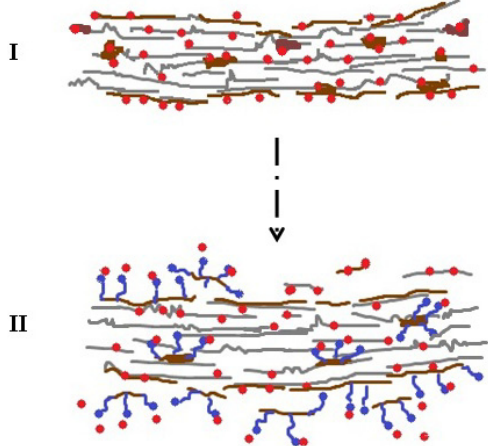
Figure 1. A schematic of enzymatic hydrolysis of lignocellulosic biomass pretreated with dilute acid technique in which part of the released lignin materials are re-deposited back onto the biomass and irreversibly adsorbed the enzyme ( I ); Treatment of dilute acid pretreated biomass with surfactants isolated part of the lignin with monomers of surfactants. This prevents irreversible adsorption of enzymes to non-productive sites of the biomass (e.g., lignin) ( II ). Brown lines: lignin, grey lines: crystalline and amorphous cellulose, red dots: enzymes, blue objects: surfactants. For simplicity, hemicellulose was not shown in this